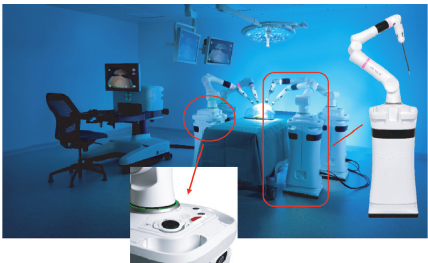
Figure 4: Versius ® Surgical System; Copyright CMR Surgical Ltd. Surgeon console (left) with a monitor mounted on it; bed side unit (Right), manipulated with help of